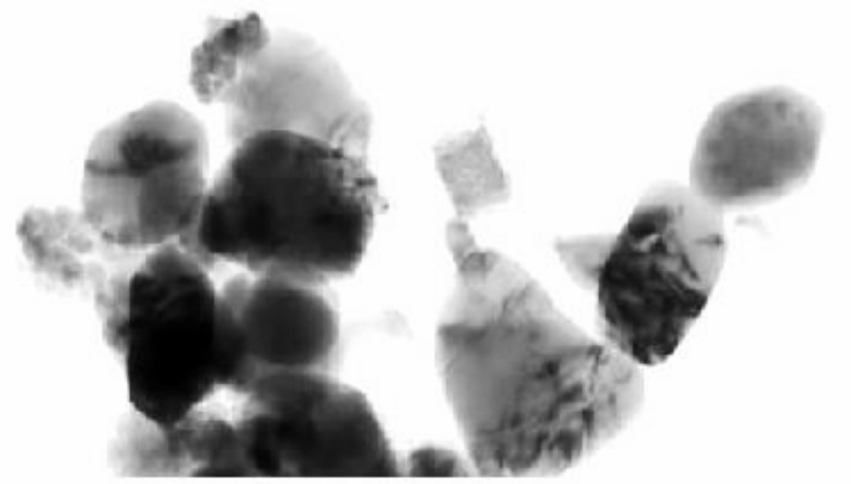
Figure 1. Transmission electron microscopic image of chitosan NPs, ranging from 50–100